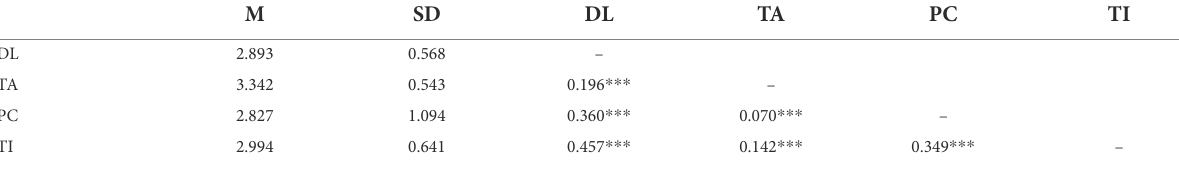
*** p < 0.001. TABLE 2 Reliabilities and validities of